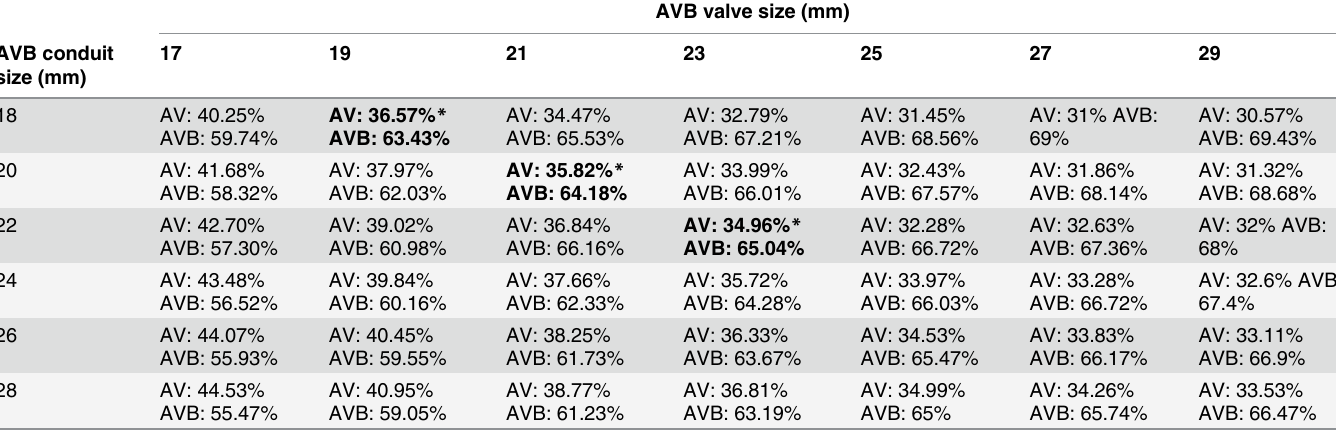
Table 2. Computed AS and AVB flow rate ratio in the presence of fixed severe AS (EOA = 0.7 cm2).